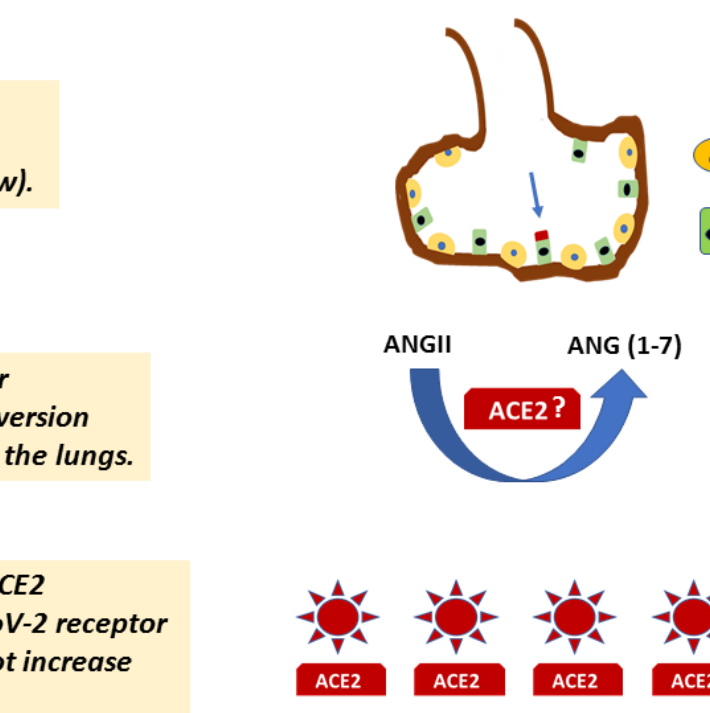
Figure 6. Expression and function of ACE2 in the lungs in the coronavirus disease 2019 (COVID-19) era. Abbreviations: ACE2, angiotensin-converting enzyme 2; SARS-CoV-2, severe acute respiratory distress syndrome coronary virus 2; ATI cell, lung alveolar epithelial type I cell; ATII cell, lung alveolar epithelial type II cell; ANG, angiotensin; RAASi, renin– angiotensin–aldosterone system inhibitors.